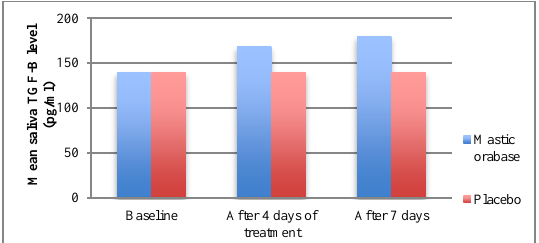
Fig. 6: Mean saliva TGF-beta values for mastic orabase treated and placebo groups at baseline, 4 days after treatment, and after 7